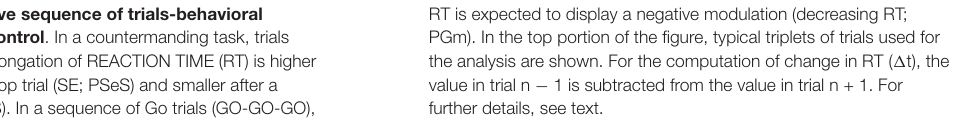
RT is expected to display a negative modulation (decreasing RT; PGm). In the top portion of the figure, typical triplets of trials used for the analysis are shown. For the computation of change in RT ( ∆ t), the value in trial n − 1 is subtracted from the value in trial n + 1. For further details, see